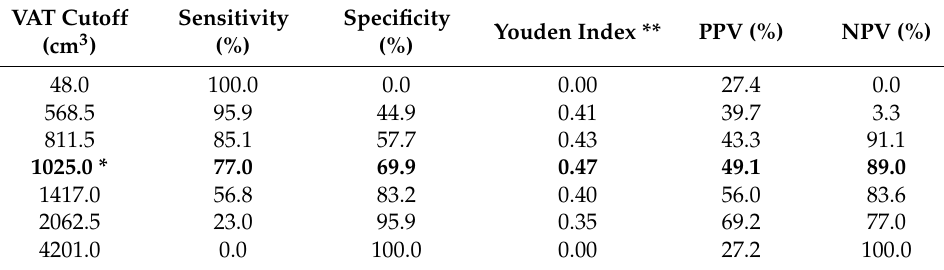
Table 3. VAT cutoff points with other relationships of sensitivity, specificity and predictive values.